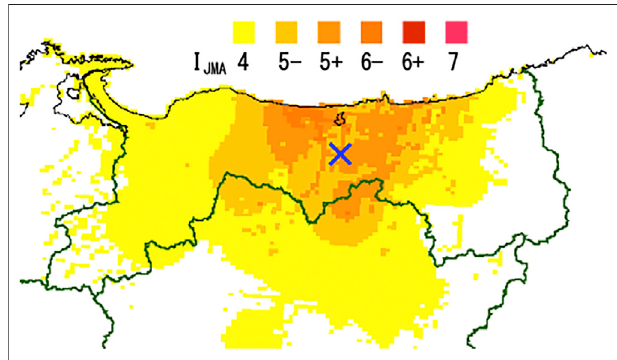
FIGURE 3 | Seismic intensity distribution of the 2016 Central Tottori Prefecture Earthquake interpolated by the JMA considering the site ampli fi cation factor (modi fi ed from the Japan Meteorological Agency, 2016b).